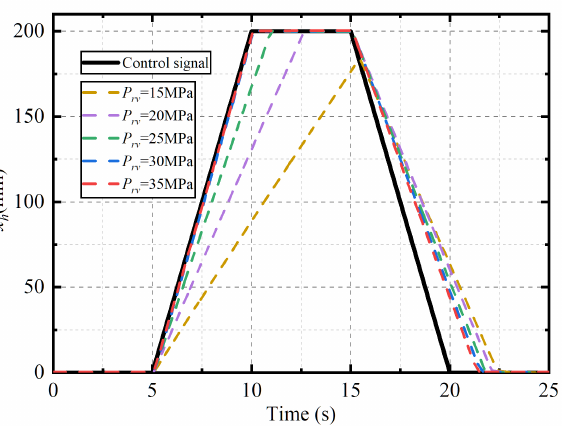
Figure 18. Displacement output, x h , at different cracking pressures of relief valve, P rv , when depth is 11